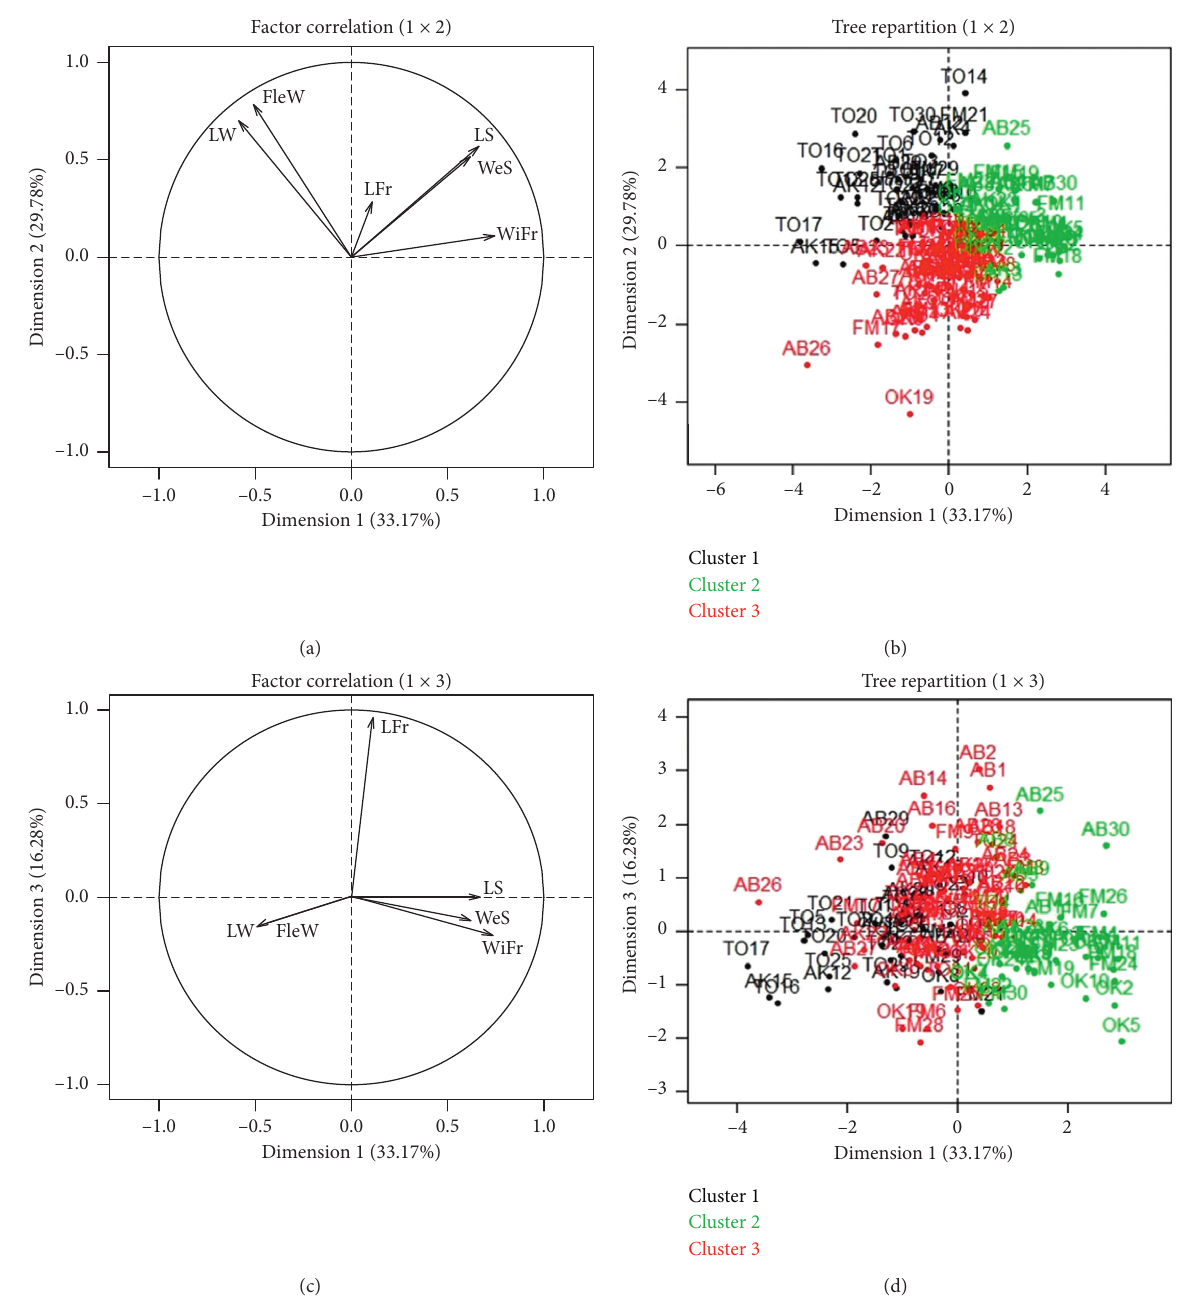
Figure 11: Projection of the trees in the space of axes 1, 2, and 3. Factor correlation for (a) axes 1 and 2 and (c) axes 1 and 3. Tree repartition in the space of (b) axes 1 and 2 and (d) axes 1 and